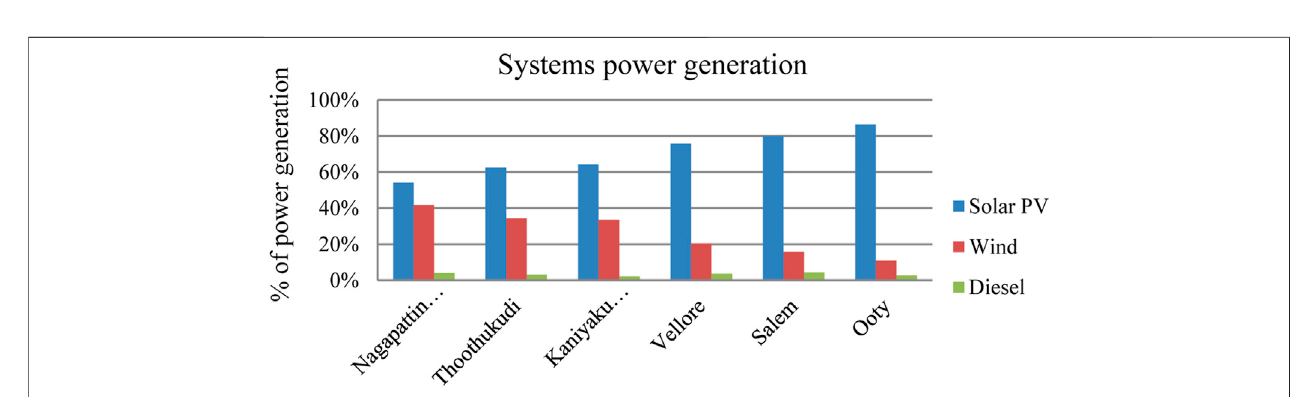
FIGURE 12 | System power generation for each selected